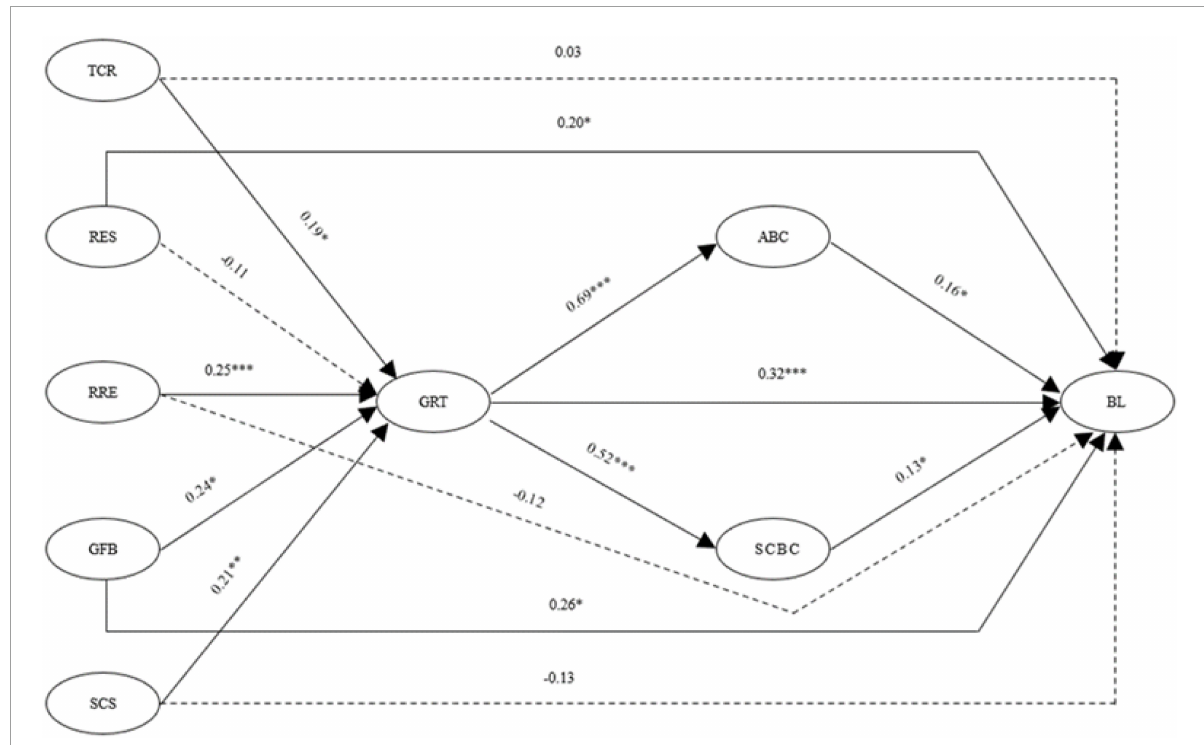
FIGURE2 Results of path analysis. TCR, technology-based consumption reduction; RES, reduction of exhibition supplies; RRE, recycling and reducing emissions; GFB, green food service; SCS, strengthening the concept of sustainability; GrT, Green Trust.